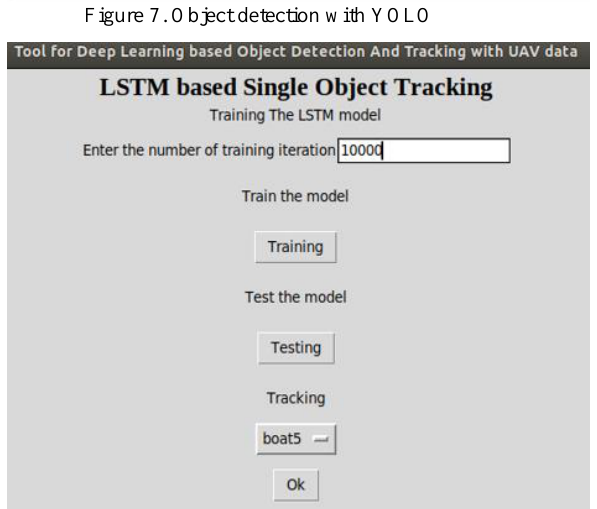
Figure 7. Object detection with YOLO